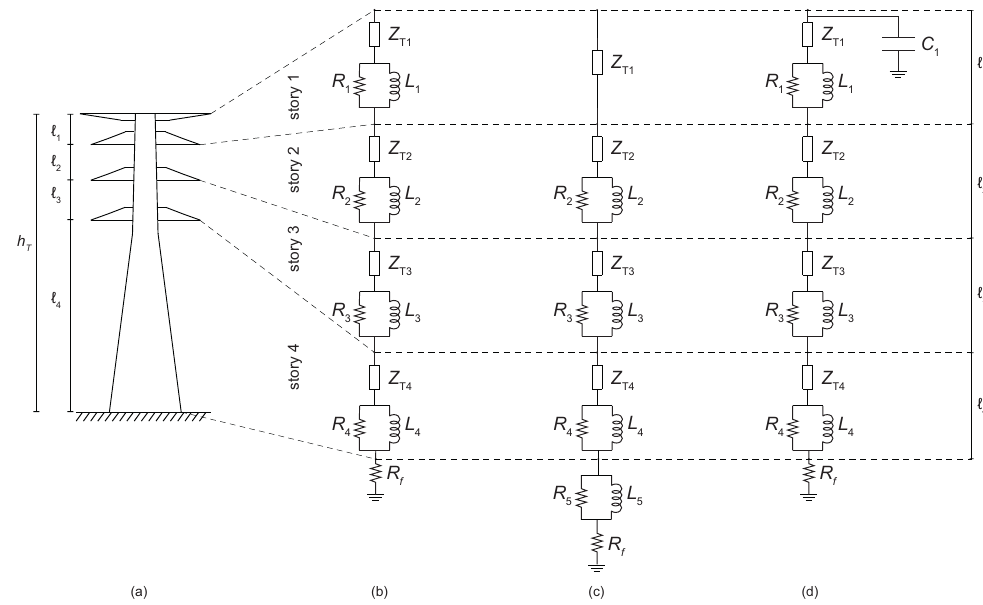
Figure 12. Sketch of a generic double-circuit tower taken as a reference ( a ), and three equivalent circuits according to different multistory models; ( b ) Ishii et al. model [55], ( c ) Baba et al. model [56], ( d ) Hashimoto et al. model